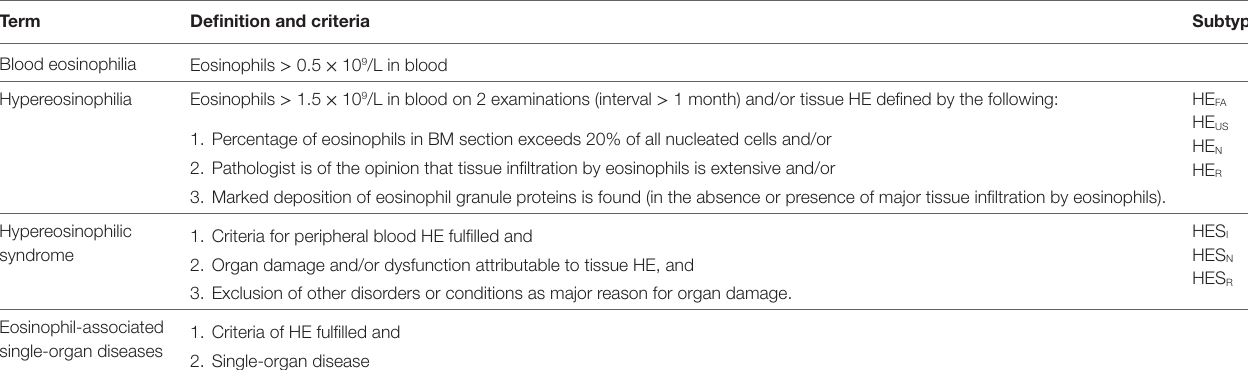
TAble 1 | Summary of the ICOG-EO’s definitions of eosinophilic